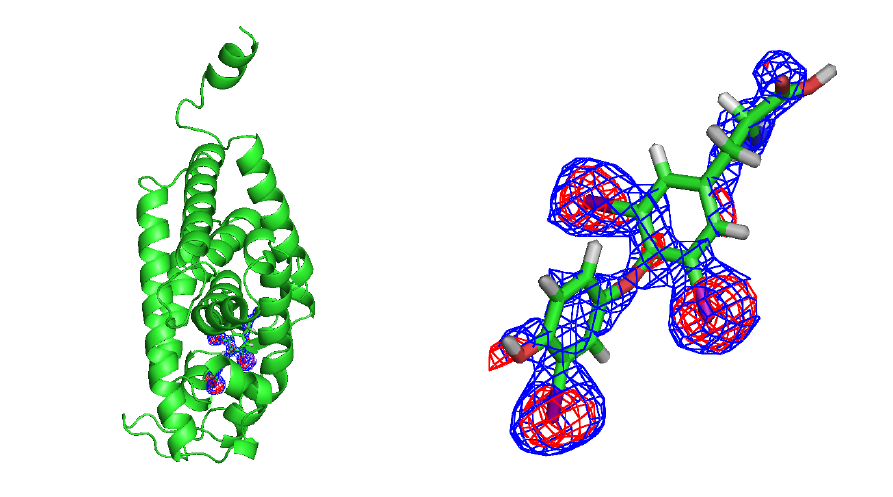
Figure 5. One ligand is buried inside the reconstructed